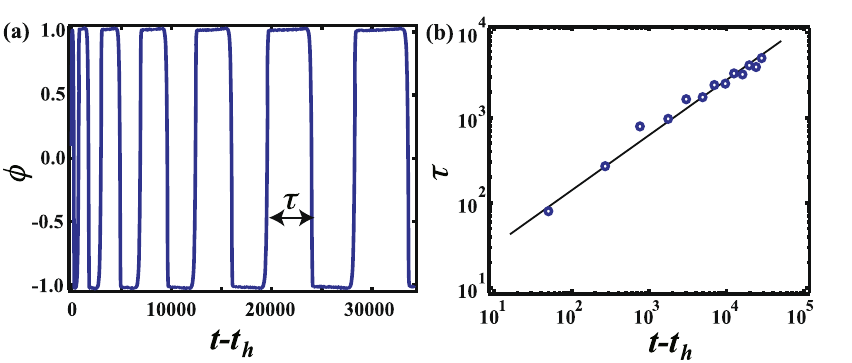
Figure 4. ( a ) Time evolution of φ at the core of a concentric circle pattern when φ = 0.1 and v tri = 0.5. φ at the core is oscillating between φ = 1 and φ = − 1. τ corresponds to a cycle of φ evolution at the core. ( b ) τ as a function of t . τ increases with time following a t 0.62 power law (solid